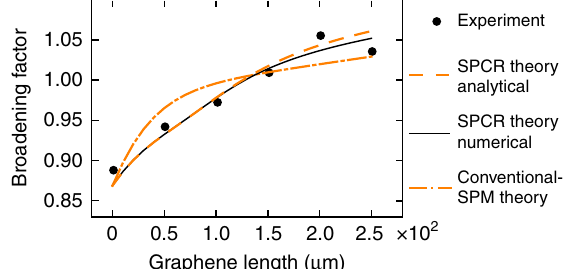
Fig. 5 Broadening factor as a function of graphene length in graphene- covered Si waveguides excited with an incoupled peak power of 1.7 W. The graph shows the experimental data points (data taken from ref. 14 ), the results from our saturable photoexcited-carrier refraction (SPCR) theory (numerical and analytical solutions from Eqs. (4) and (5)), and the results from the theory for conventional self-phase modulation (SPM) using graphene ’ s effectively observed χ eff (3) = − 10 − 7 esu. The graphene lengths used here are relatively short because of the strong